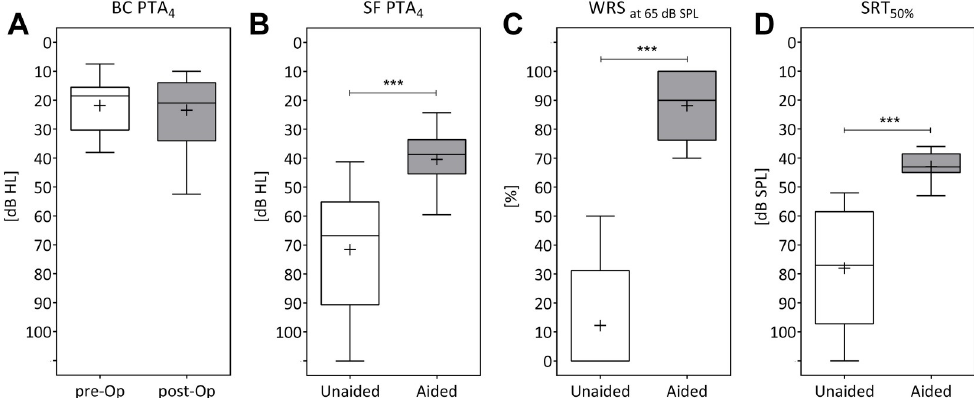
Fig 4. Audiological outcomes. Audiologic results comparing pre- with postoperative outcomes of bone conduction thresholds (4A), aided and unaided outcomes of hearing thresholds in sound field (4B), word recognition score at 65 dB SPL (4C) and 50% speech reception thresholds (4D). Boxes indicate the 25 th and 75 th percentiles. Mean and median are given as plus signs (+) and horizontal lines. Minimum and maximum values are depicted by whiskers; ��� p < 0.001.